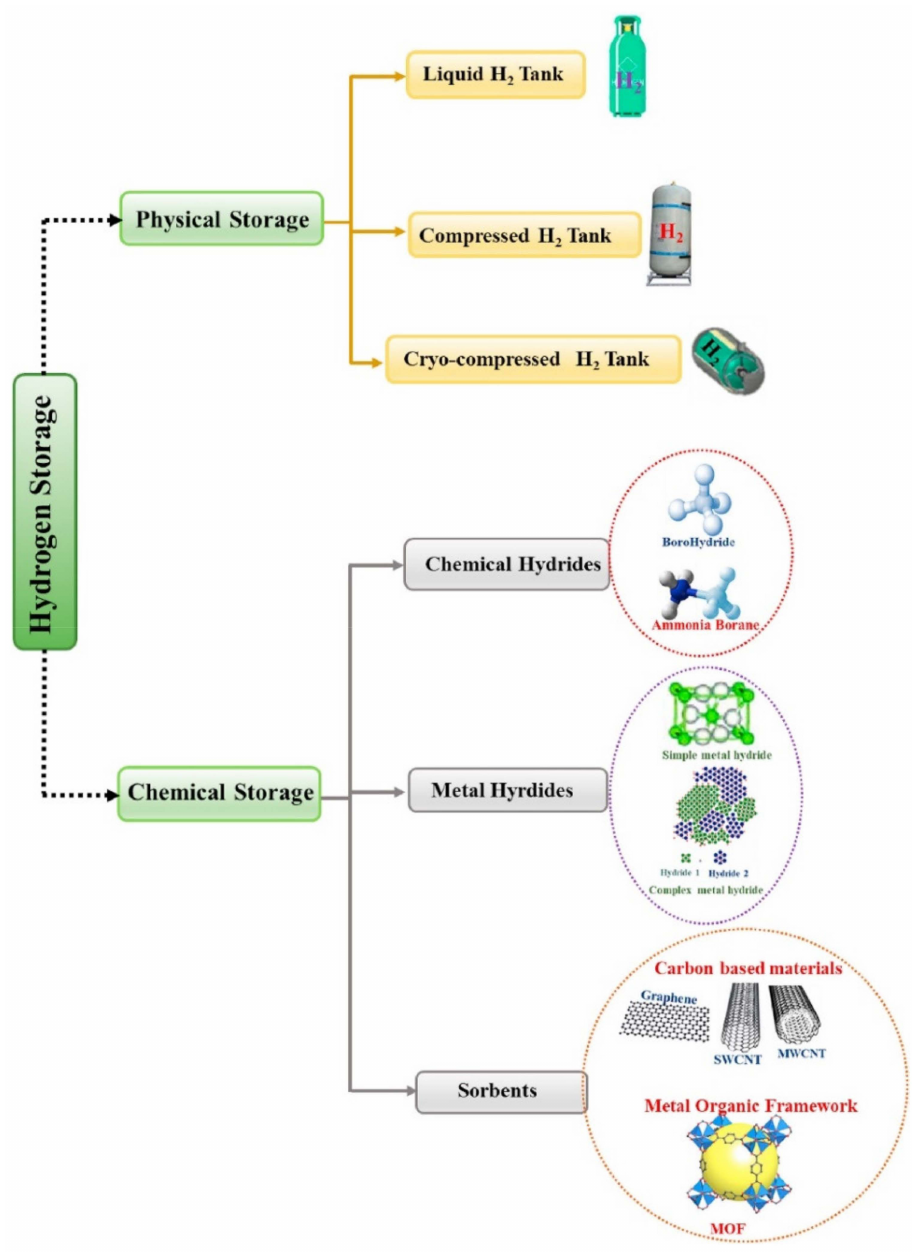
Figure 13. Various mechanisms for hydrogen storage [129]. Reproduced with permission from Elsevier,